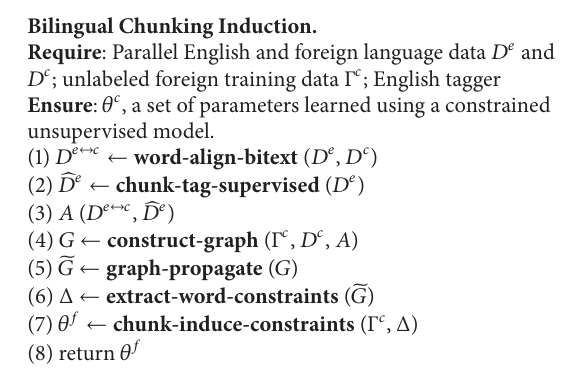
Algorithm 1: Graph-based unsupervised chunking approach.